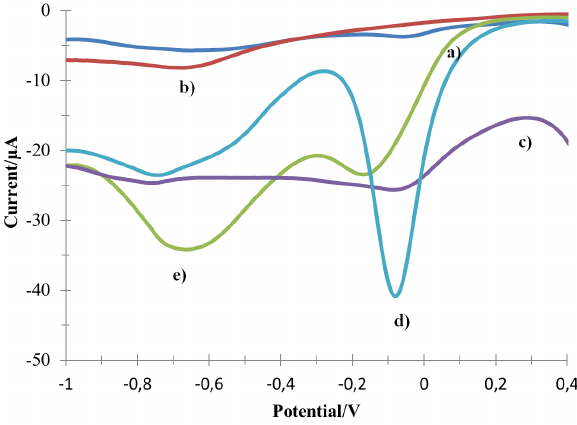
Figure 3: The SW voltammograms of GC electrode in acetate buffer solution: a) bare electrode; b) immersed in 6-chloropyridin-3-amine; c) modified with 6-chloropyridine moieties, d) bare electrode + 4.0 x 10 -4 M copper (II) ions and e) modified with 6-chloropyridine moieties after complexation with copper (II) ion for 45 min. The SW amplitude, 100 mV, SW frequency, 100